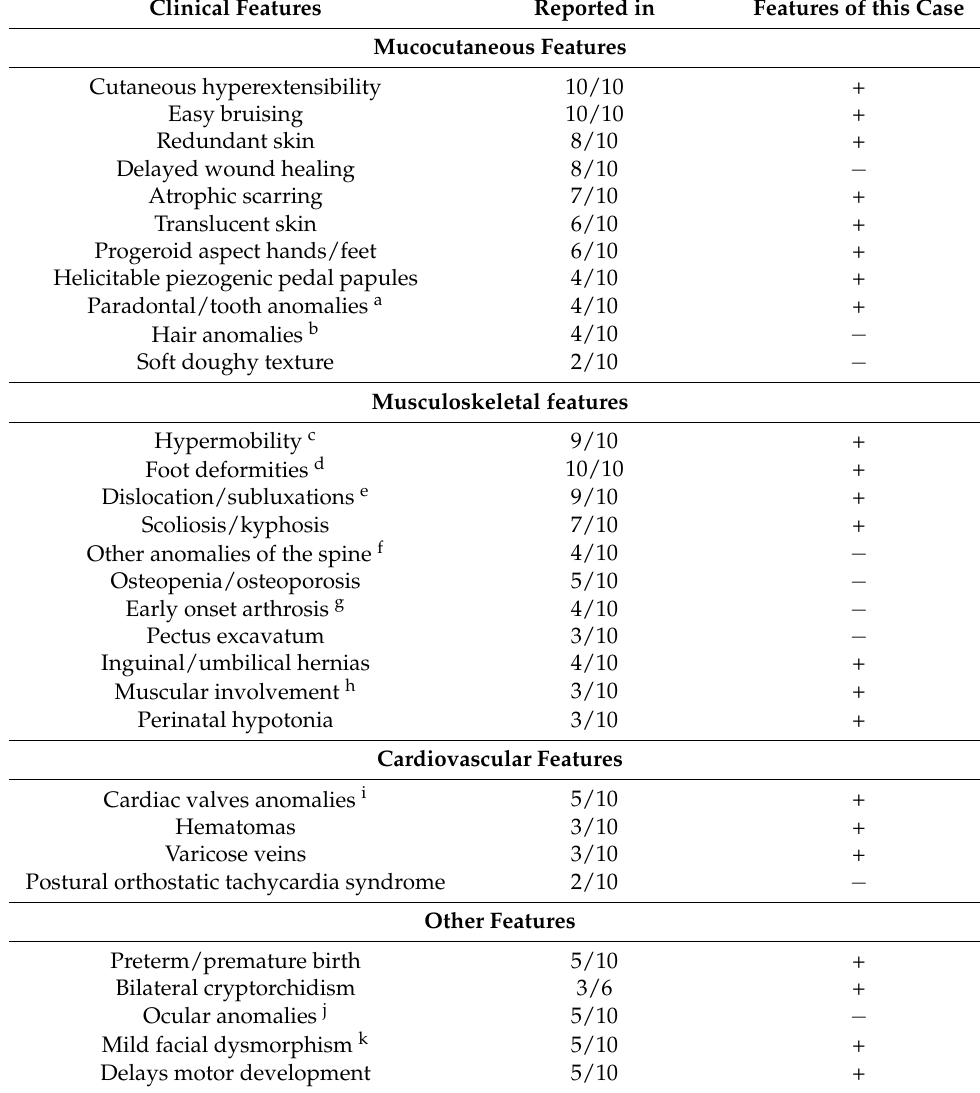
Table 1. clEDS2 reported clinical features in this report and their overall frequencies in published